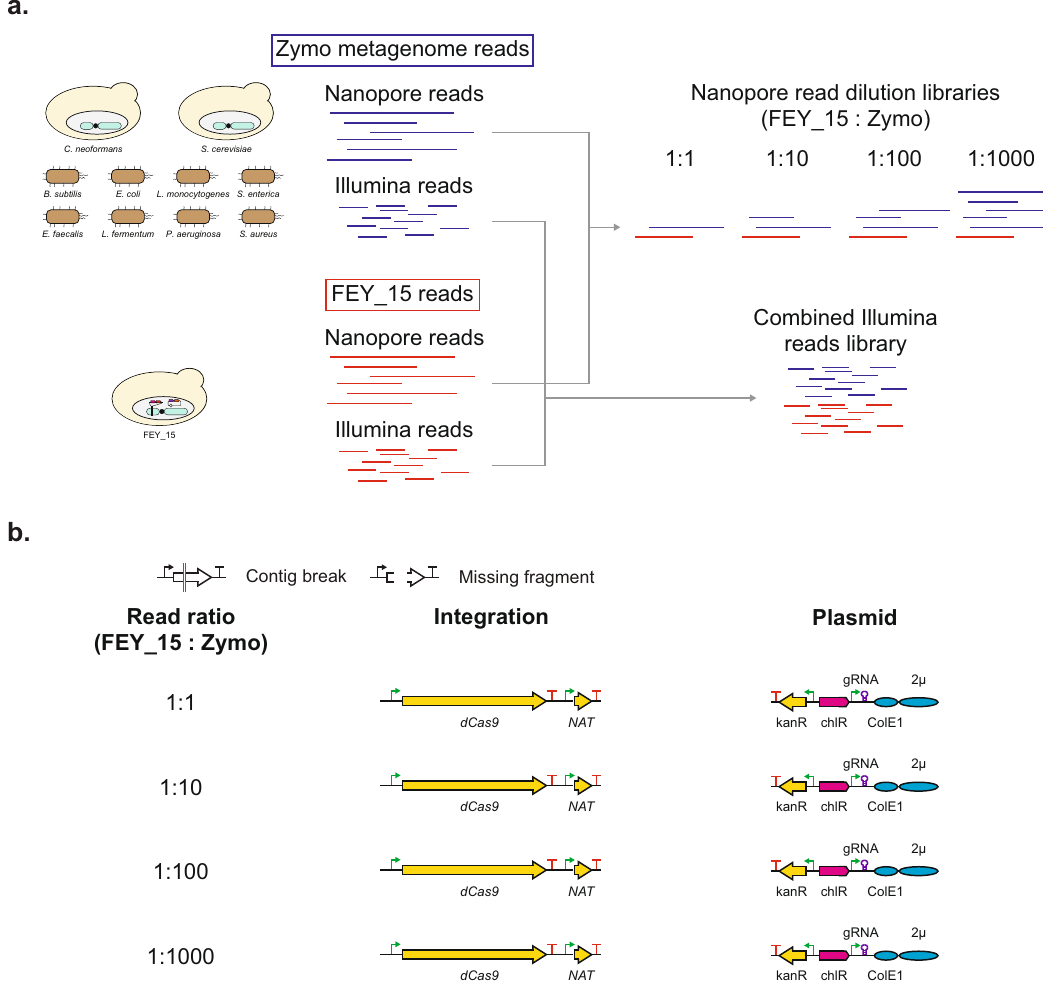
Fig. 6 Resolving signatures of engineering in an in silico metagenome assembly. a Publicly available reads from Zymo ’ s mock metagenome were combined with reads from the engineered S. cerevisiae strain FEY_15. b Visual representation of the BLASTN results for the in silico metagenome. Failure modes of genome assemblies were shown as red lines (contig break) and white spaces (missing fragment). The colored pathways and plasmids represent assemblies where all engineering signatures were found in contiguous